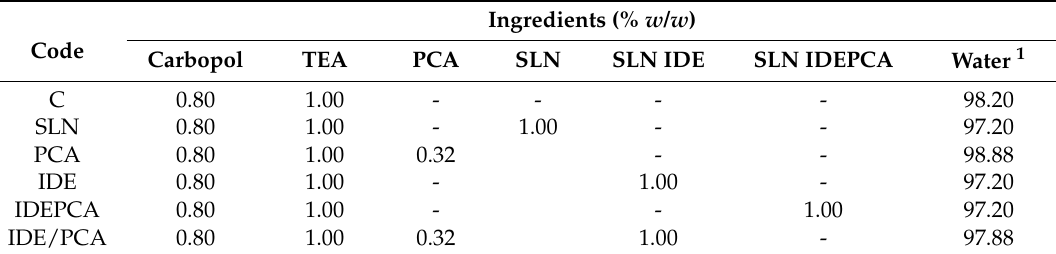
Table 3. Gel composition (% w / w ).